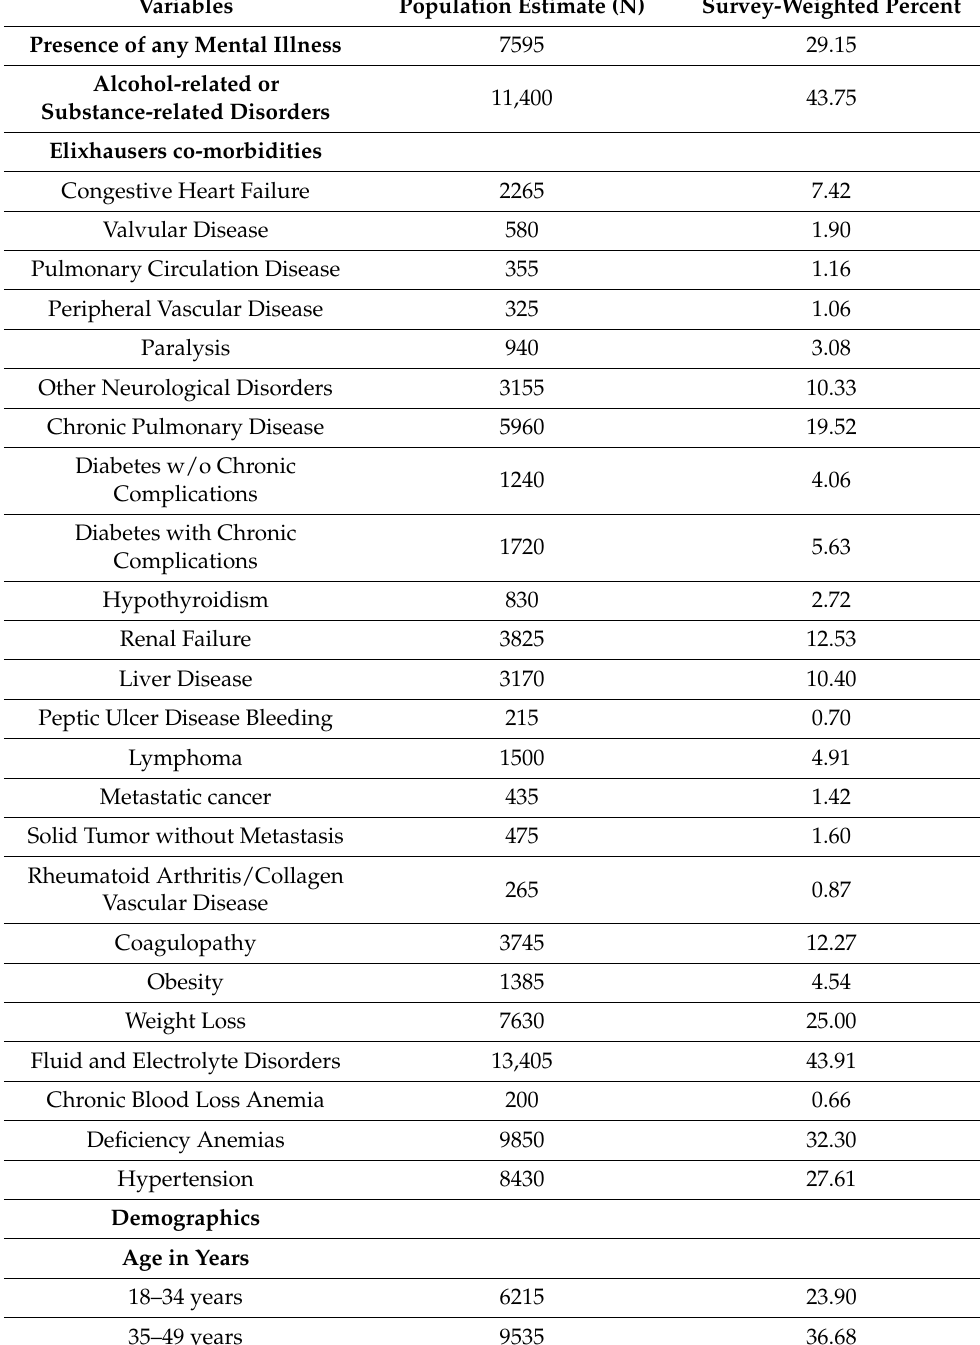
Table 1. Characteristics of primary HIV discharges in the United